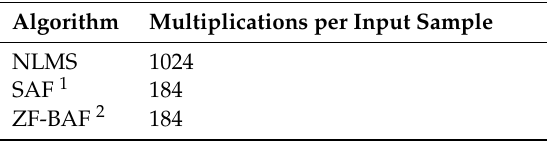
Table 4. Computational Burden in test case 2.